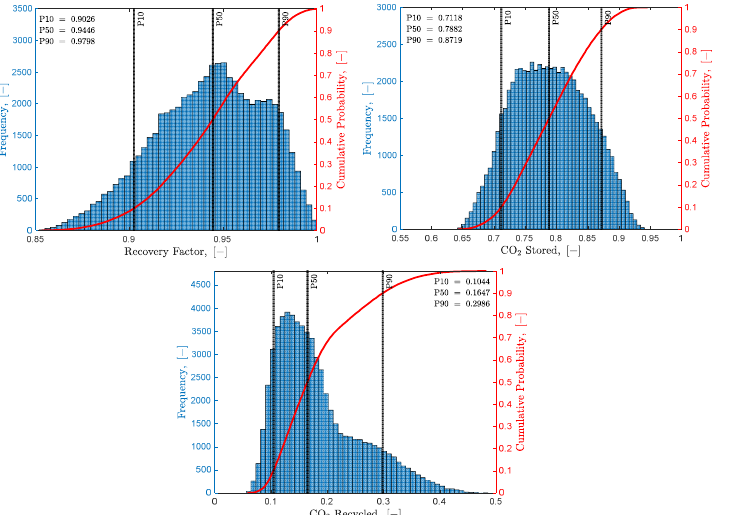
Figure 15. Results from MC simulation showing the recovery factor (top left), CO 2 stored (top right), and CO 2 recycled (bottom) with 65,000 runs.